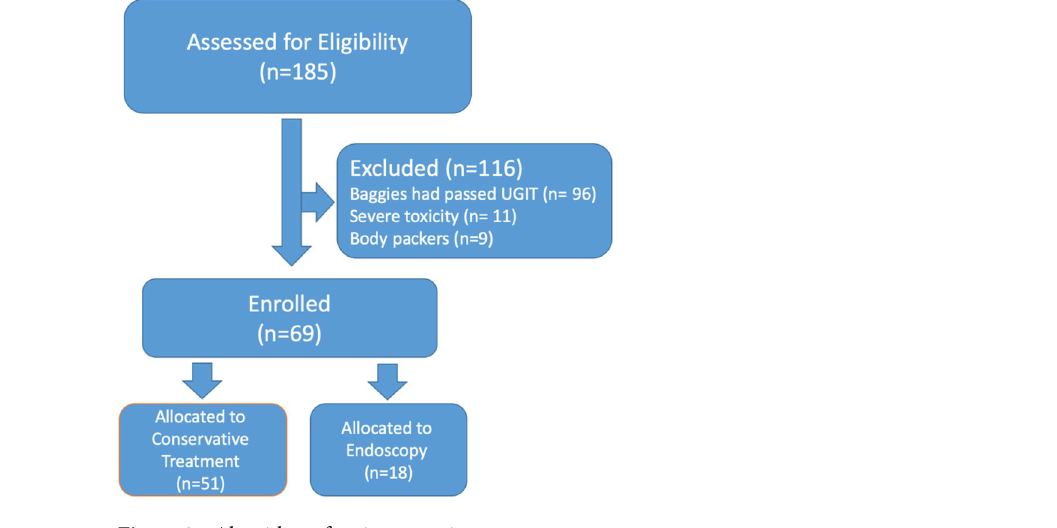
Figure 2. Algorithm of patient recruitment.